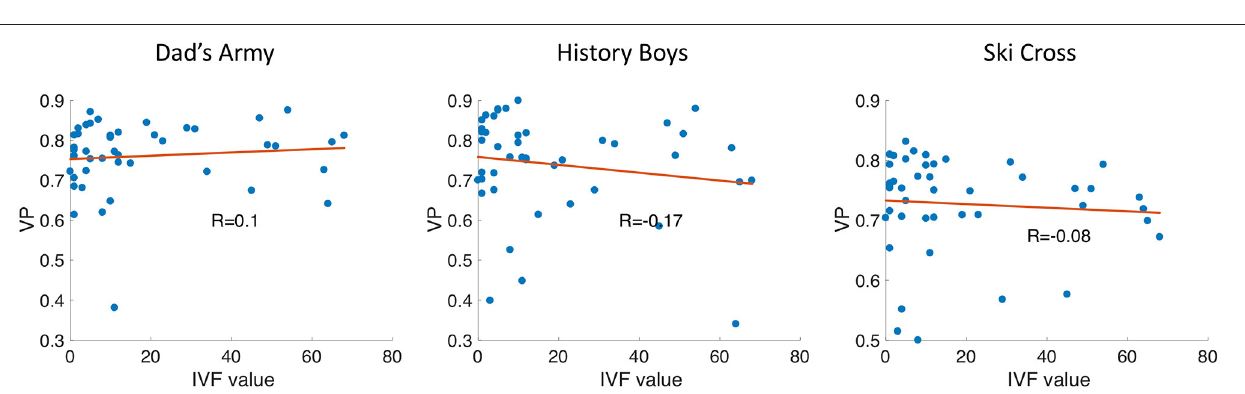
FIGURE 12 | Scatter plots showing the VP vs. the IVF score of each participant. R is the correlation coefficient.